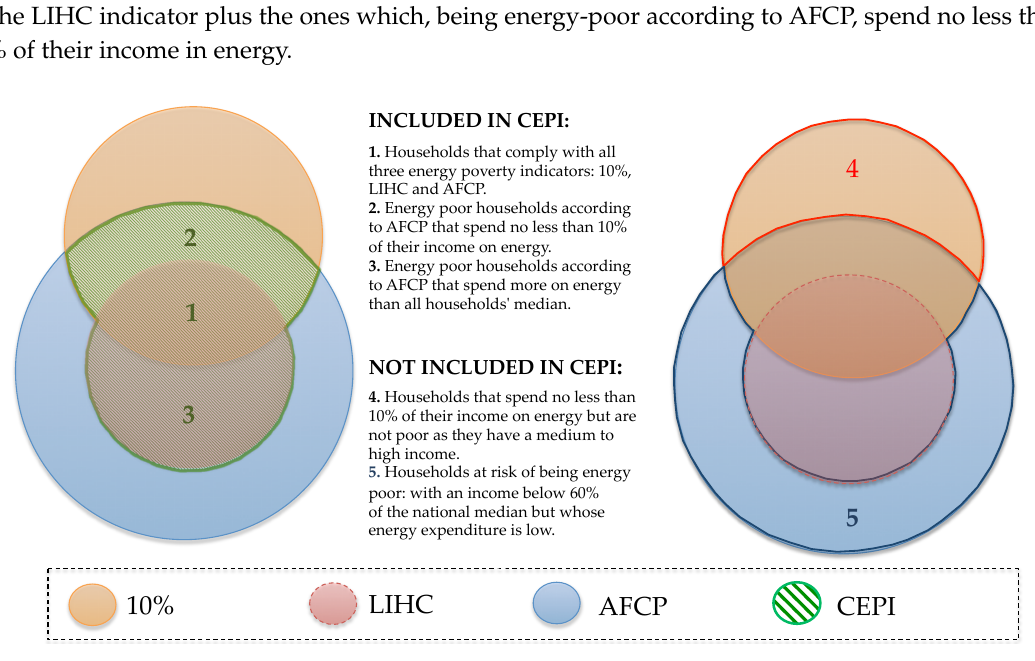
Figure 4. Demarcation of the Compound Energy Poverty Indicator (CEPI).